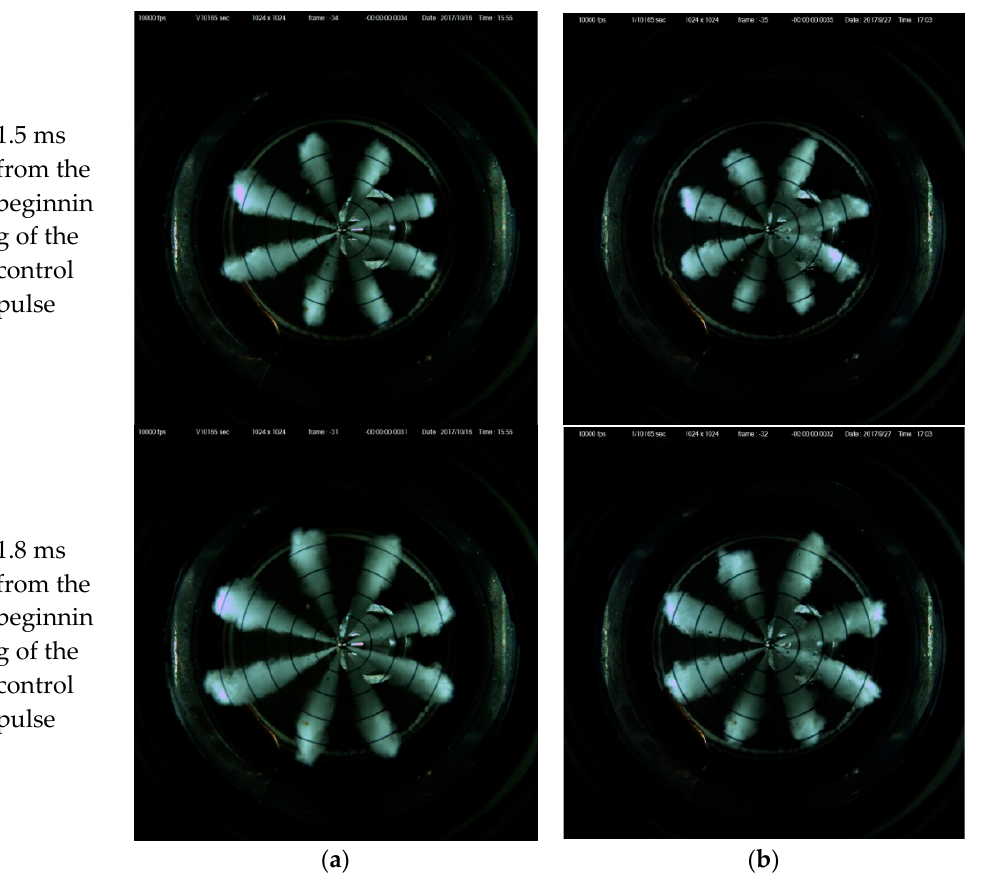
Figure A1. Development of fuel sprays in a constant volume chamber with nozzle 1 ( a ) and nozzle 2 ( b ) with a rail pressure of 100 MPa.